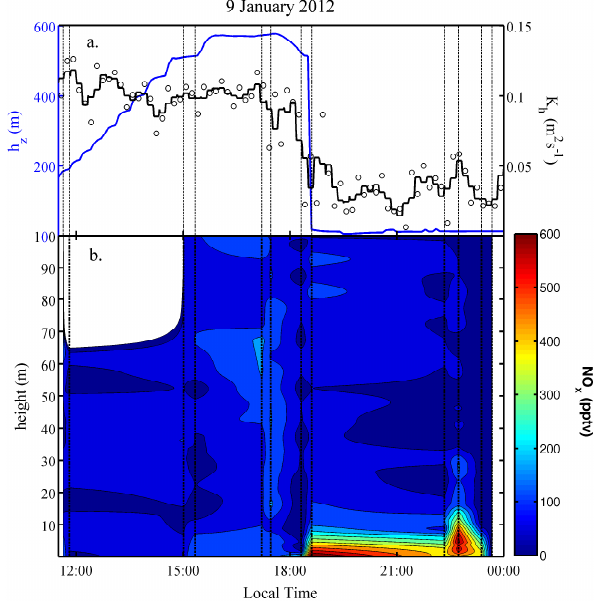
Figure 2. Balloon profiles (vertical dashed lines) from 9 Jan- uary 2012: (a) modelled mixing height h z (10min running mean) and observed turbulent diffusion coefficient of heat K h at 1m (sym- bols: 10min averages; black line: 30min running mean); (b) inter- polated vertical profiles of NO x mixing ratios with contour lines representing 60pptv intervals. The lower 100m appear well mixed during the day, while after collapse of the convective boundary layer in the early evening snow emissions of NO x are trapped near the surface, causing a strong increase in mixing ratios near the